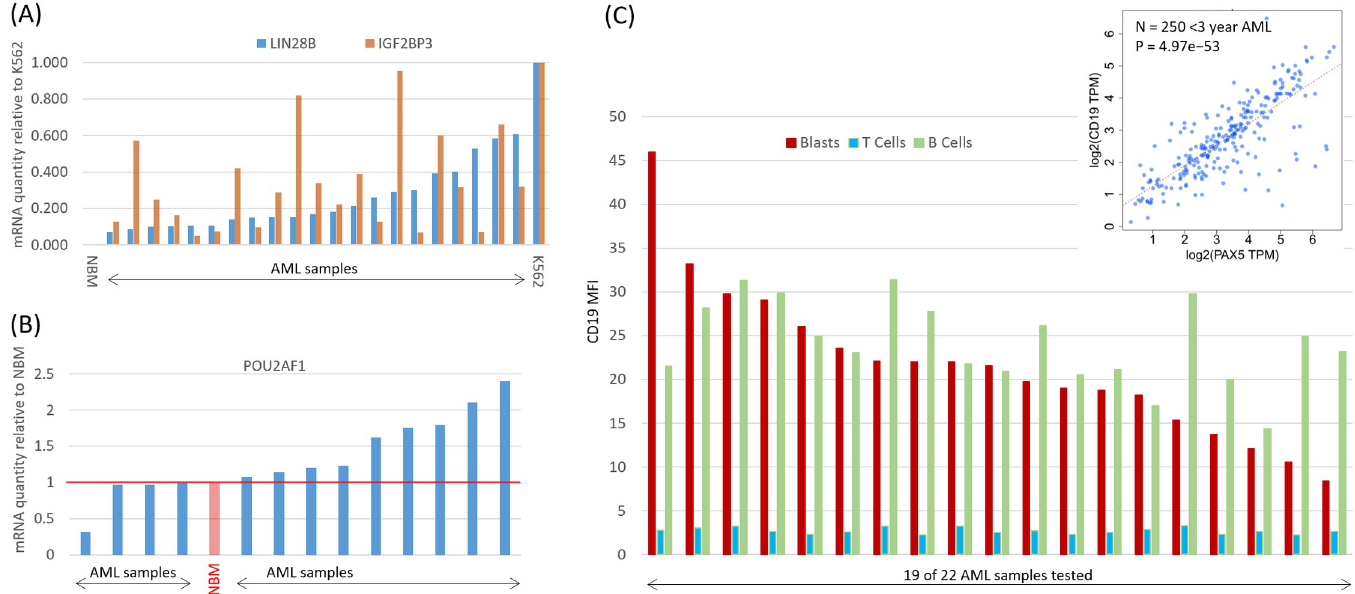
Fig 7. B-cell associated genes in infant AML are expressed at functionally significant levels. ( A, B ) LIN28B , IGF2BP3 , and POU2AF1 , are expressed at physiologically meaningful levels in infant AML. Shown are real-time quantitative PCR (RT qPCR) mRNA abundance measurements in 23 infant AML samples (22 for POU2AF1 ) compared to K562 cells. For comparison, expression in a pool of seven normal bone marrow samples is also shown. ( C ) The expression of CD19 protein in infant AML blasts is at levels comparable to that of B cells. Shown are flow-cytometry mean fluorescence intensity (MFI) values for AML blasts, T cells and B cells from 19 of 22 infant AML samples successfully tested. Inset shows the high correlation of the PAX5 gene and its putative target CD19 .